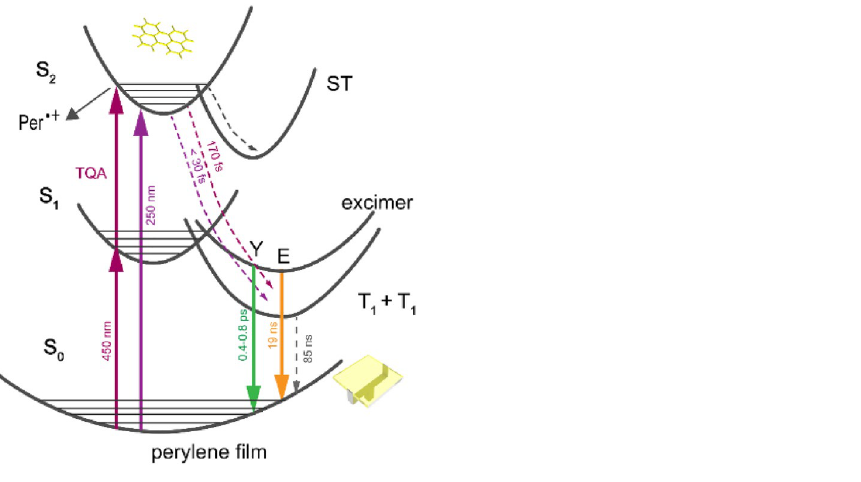
Figure 7. Photophysical pathways of perylene film at λ ex = 450 and 250 nm. Per •+ is perylene dimer radical cation. Y is hot excimer and E is relaxed excimer. T 1 + T 1 is the triplet pair state generated through singlet fission. ST is self-trapped excitonic